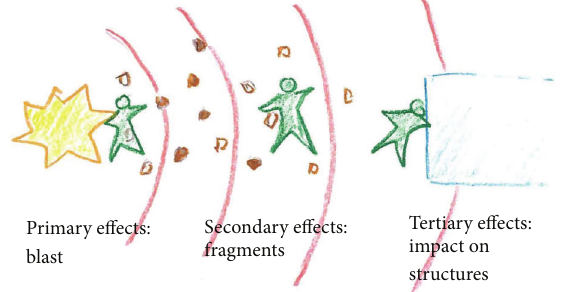
Figure 2: Blast effects on humans (green), explosion (yellow), fragments (brown), and blast wave